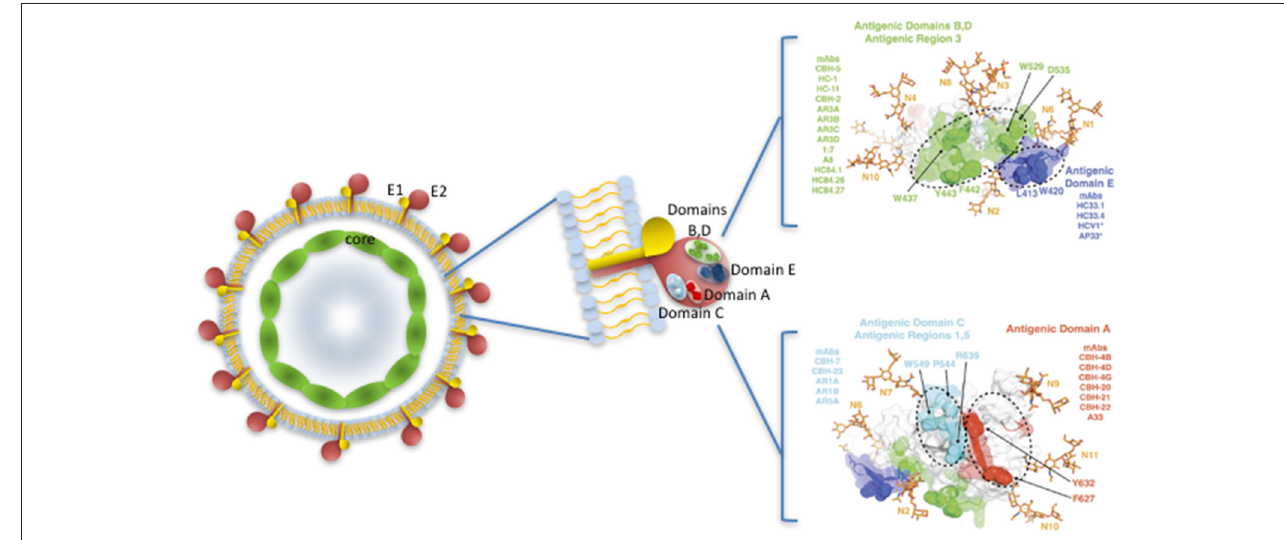
FIGURE 1 | HCV virus like particle showing E1 and E2 protein dimers embedded in a lipid bilayer, surrounding the core nucleocapsid. Major neutralizing regions are situated on the surface of the E2 protein. Antigenic domains and antigenic regions with the key binding sites of key human Mabs are shown on the right, with the neutralizing antibody face (antigenic domains B, D; Antigenic Region 3; antigenic domain E) above and the non-neutralizing face (antigenic domains A,C) of E2 below. Adapted from Fauvelle et al. (2016) and with permission from Prof S Foung.